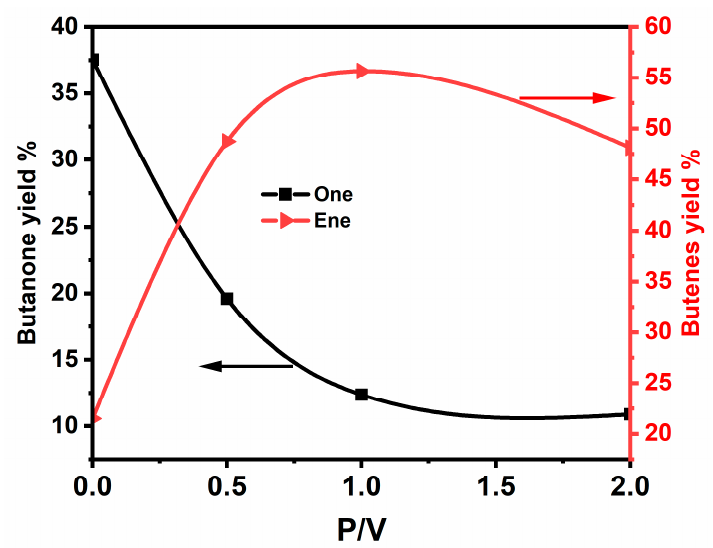
Figure 9. Catalytic activity of P modified V 2 O 5 (3.6 wt%)/ZrO 2 catalysts in air mixture depending on P/V ratio in butenes and butanone yield.